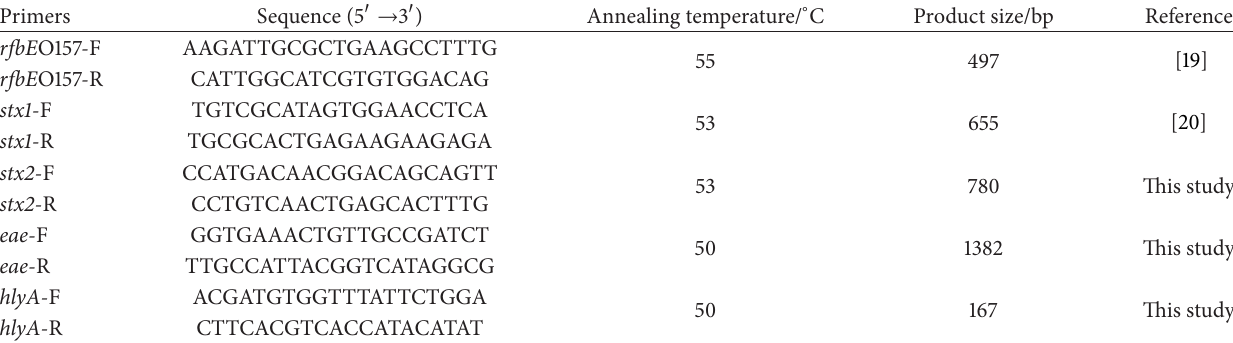
Table 1: Primers for detection of virulence genes in EHEC O157